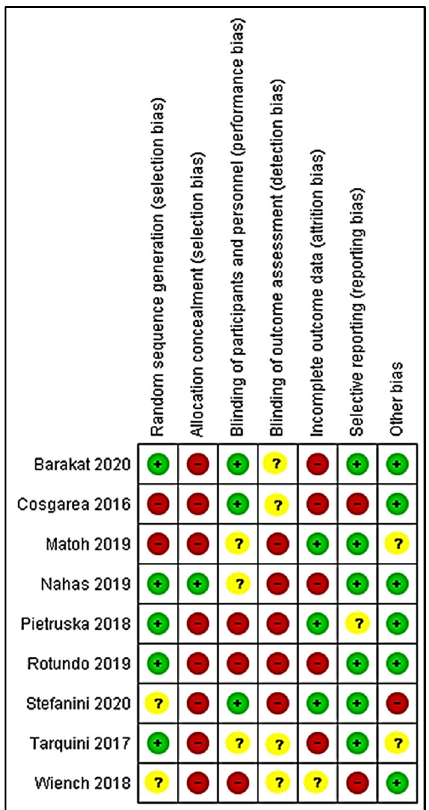
Figure 3. Risk of bias assessment for clinical trial.